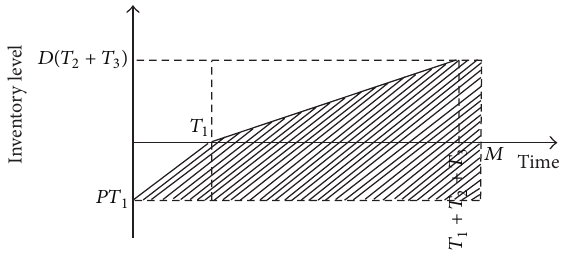
Figure 4: The total accumulation of interest earned when 𝑀 ≥ 𝑇 1 + + 𝑇 𝑇 2 3